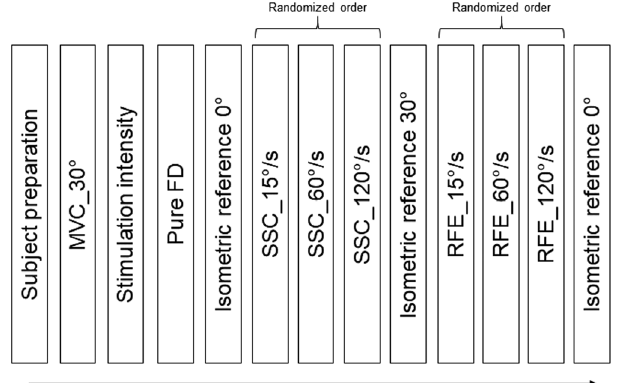
Figure 1. Experimental design of the study. Following participant preparation, a maximum voluntary contraction (MVC) was performed at a 30° thumb abduction angle and the stimulation intensity was then adjusted to produce 50–60% of the MVC force. Next, a force depression (FD) test at 60°/s shortening velocity and a corresponding isometric reference contraction at 0° were performed. Stretch-shortening cycles with varying stretch velocities (15°/s, 60°/s, 120°/s) and a given shortening velocity (60°/s) and shortening magnitude (30°) followed in a randomized order. Then, an isometric reference contraction at 30°, followed by the randomized RFE tests at varying stretch velocities (15°/s, 60°/s, 120°/s) were performed. Last, an isometric reference contraction at 0° was performed to assess muscle fatigue.